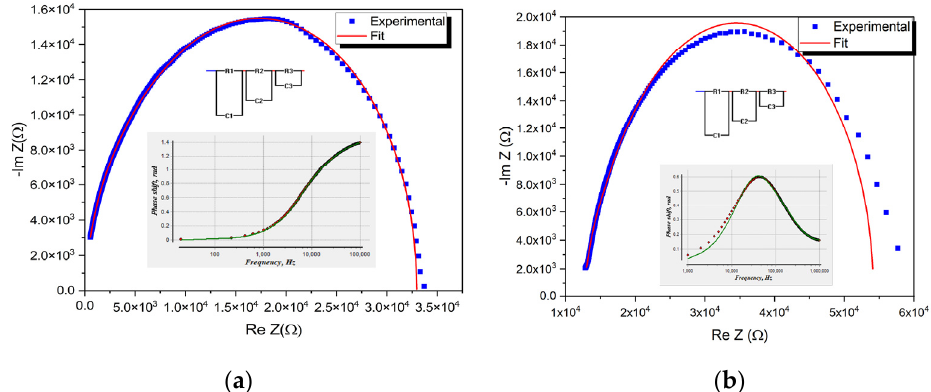
Figure 9. Measured Cole–Cole plots and the fitting for the devices with ( a ) an electrospun cathode; ( b ) a neat film cathode. Table 1. Parameters of the equivalent circuit for the electrospun and neat film cathodes.